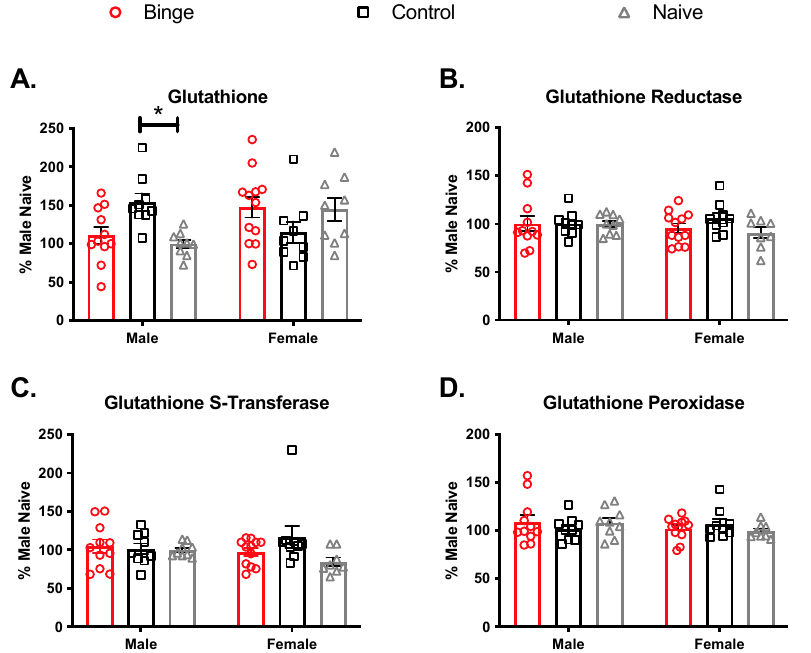
Figure 6. Effects of multiple binge on antioxidant competence in the hippocampus. Elevated GSH level was detected in hippocampal samples of males treated with control diet compared to naïve ( A ). There were no significant of sex or binge treatment in ( B ) Glutathione reductase, ( C ) Glutathione S-Transferase, or ( D ) Glutathione Peroxidase assays activities. Bars depict ± SEM from percent naïve in (9–12) animals. * p < 0.05.